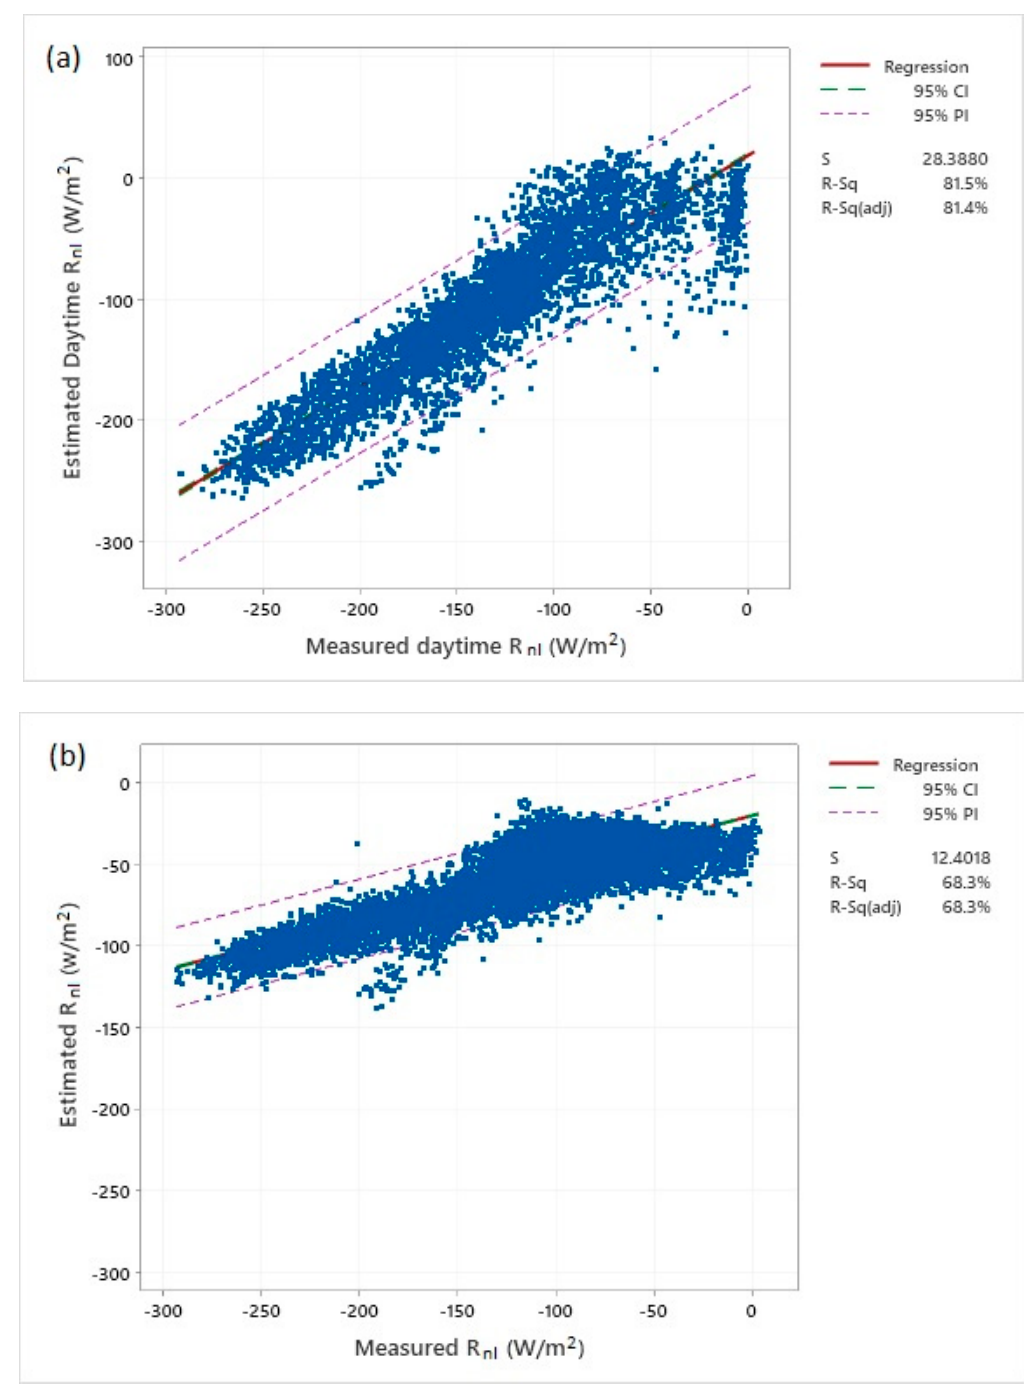
Figure 19. Comparison of measured and estimated hourly net longwave irradiances using the local calibrated coefficients at Athalassa for the period 2016–2017 (validation dataset), during ( a ) daytime and ( b ) all day